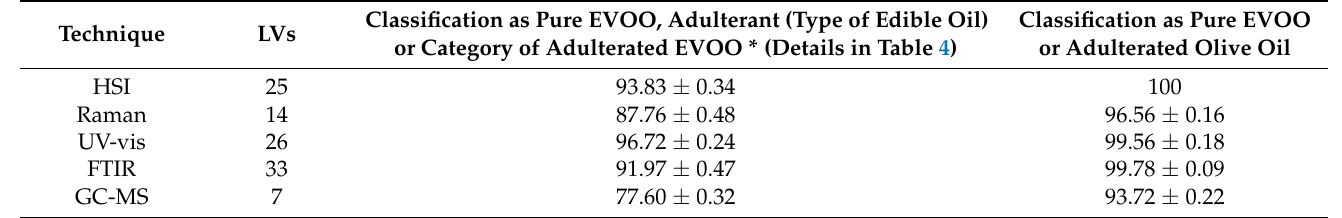
Table 3. PLS-DA models of different techniques in the classification of edible oils, pure EVOO and adulterated olive oil (%CC pred . a